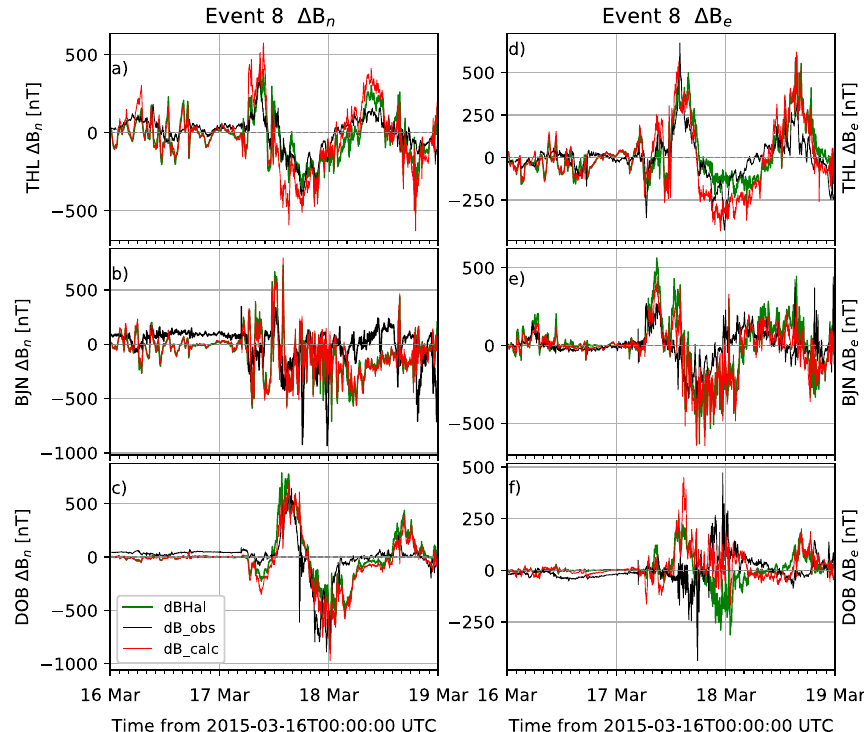
Fig. 5. Two components of ground magnetic perturbations, D B n (left side panels) and D B e (right side panels), at ground magnetometer stations THL, BJN, and DOB for event 8. The black line shows the observed perturbations, the red line shows the model total ground perturbations, and the green line shows the modelled perturbation due to Hall